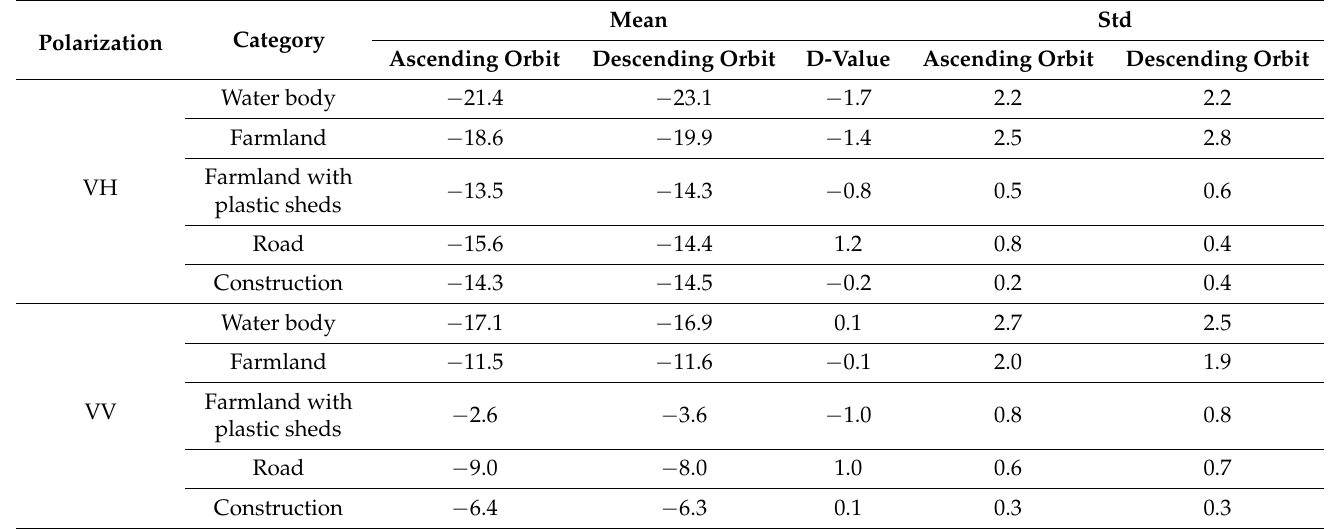
Table 4. Statistical values of backscattering coefficients (Unit: